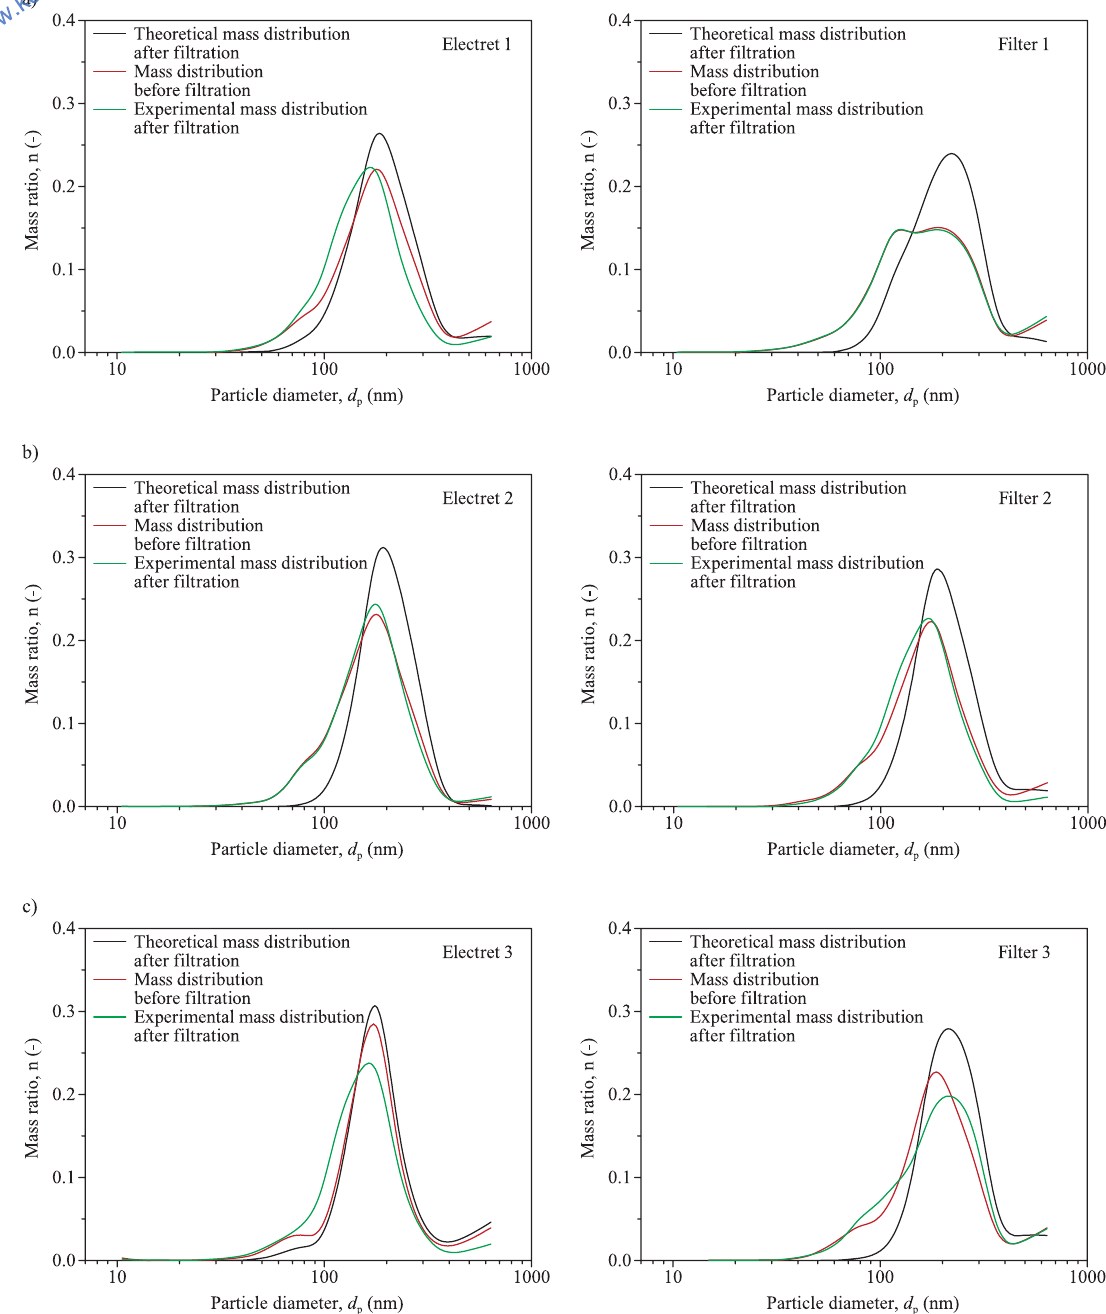
Fig. 7 Distribution of DEPs’ mass ratio vs. particle diameter: (a) Electret 1 and Filter 1, (b) Electret 2 and Filter 2, (c) Electret 3 and Filter